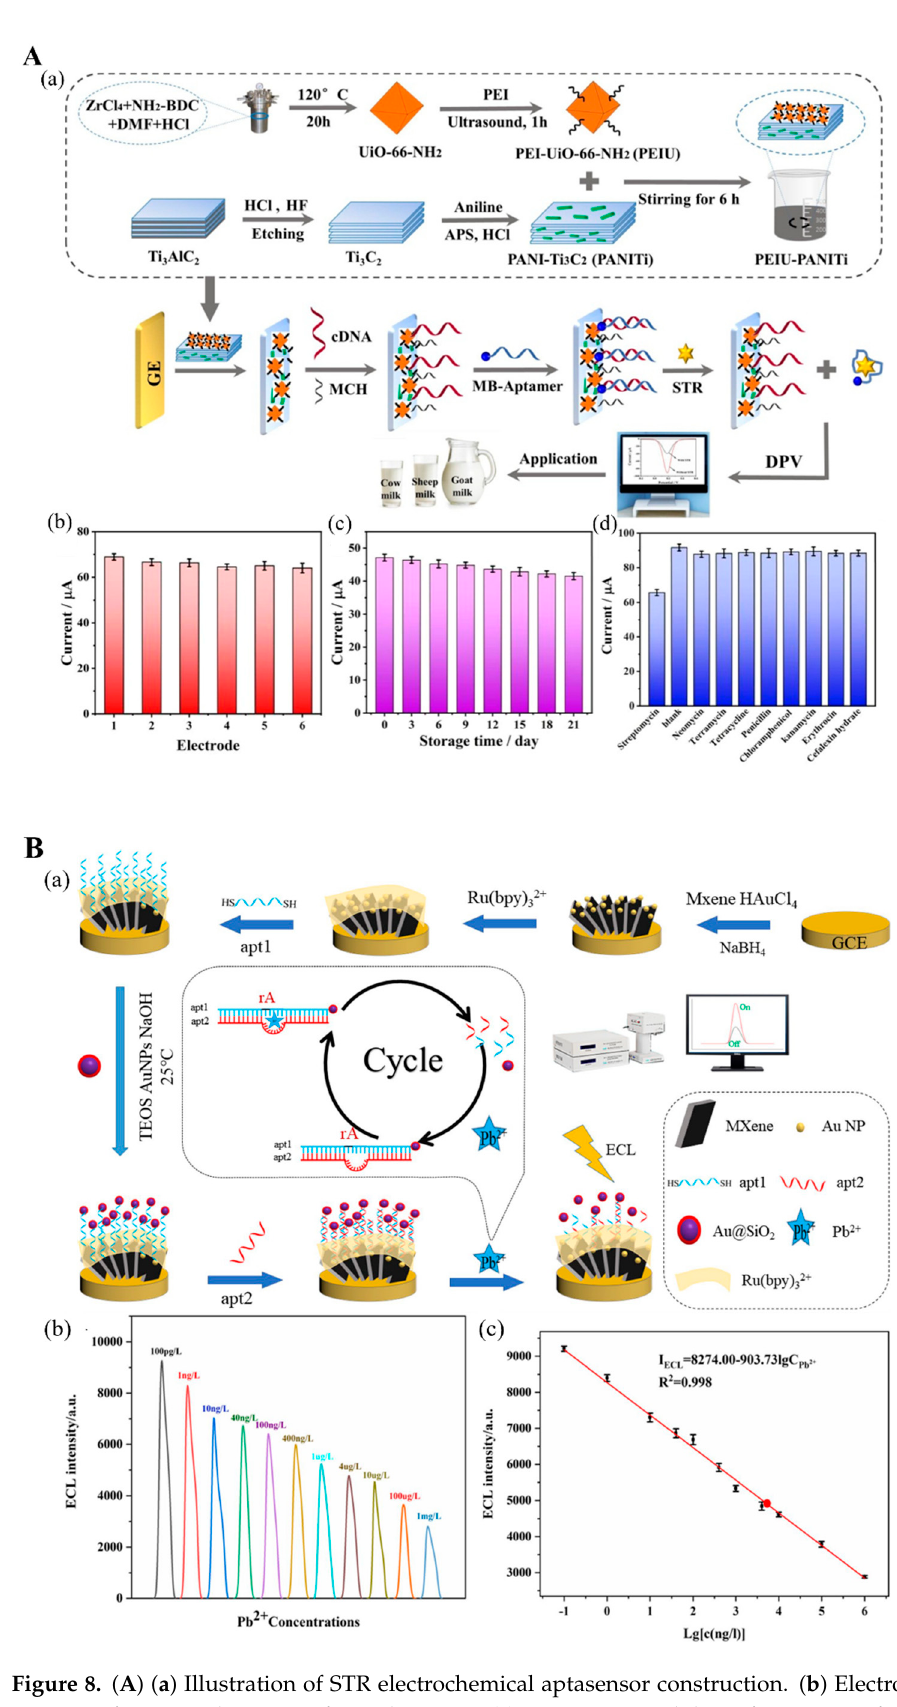
Figure 8. ( A ) ( a ) Illustration of STR electrochemical aptasensor construction. ( b ) Electrochemical response for six replications of STR detection. ( c ) Aptasensor stability after storing for 21 days. ( d )